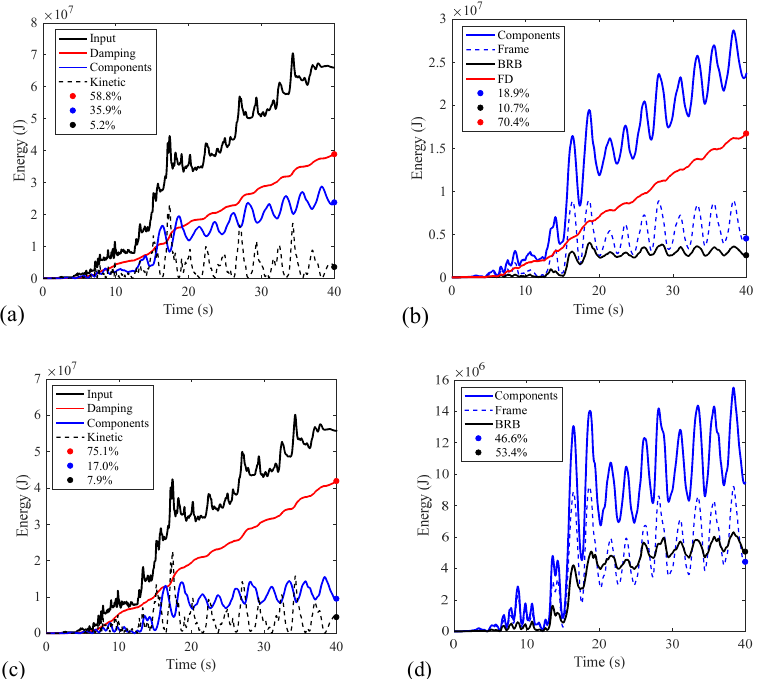
Figure 17. Seismic‑energy analysis (Imperial Valley‑06 case, PGA = 400 cm/s 2 ): ( a ) energy composi‑ Figure 17. Seismic ‐ energy analysis (Imperial Valley ‐ 06 case, PGA = 400 cm/s 2 ): ( a ) energy composi ‐ tion time‑histories (FBRB‑BF); ( b ) energy dissipated by the components (FBRB‑BF); ( c ) energy com‑ tion time ‐ histories (FBRB ‐ BF); ( b ) energy dissipated by the components (FBRB ‐ BF); ( c ) energy com ‐ position time‑histories (BRB‑BF); and ( d ) energy dissipated by the components position time ‐ histories (BRB ‐ BF); and ( d ) energy dissipated by the components (BRB ‐ BF).